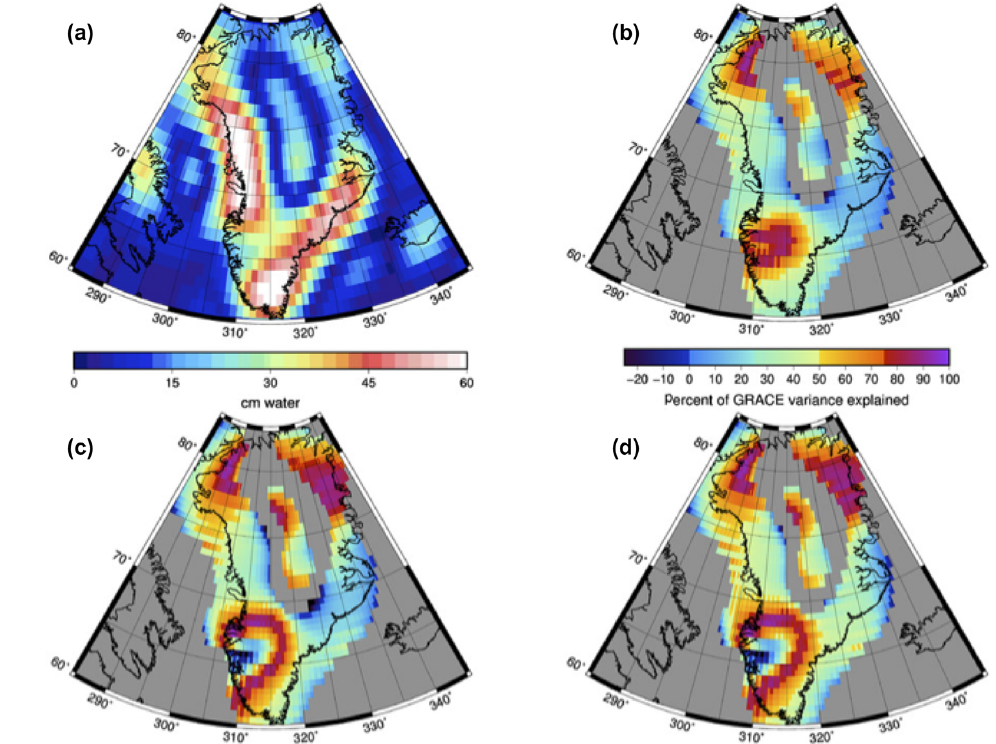
Figure 12. GRACE variance (a) and percent of GRACE variance (PVE; Eq. 4) explained by various models: (b) RACMO2-SMB-only model, (c) SMB-only simulation, and (d) SMB + FF simulation. Colorbar in (a) applies to the colormap in (a) , while the colorbar in (b) applies to the colormap in (b) – (d)